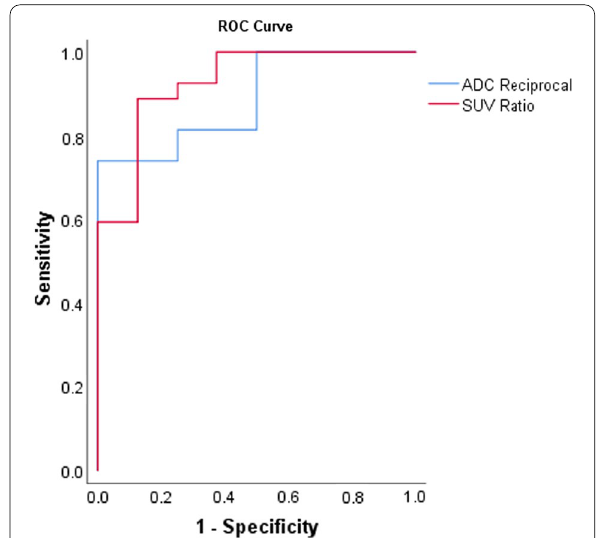
Fig. 3 Receiver operating characteristic (ROC) curve of SUV ratio and ADC reciprocal